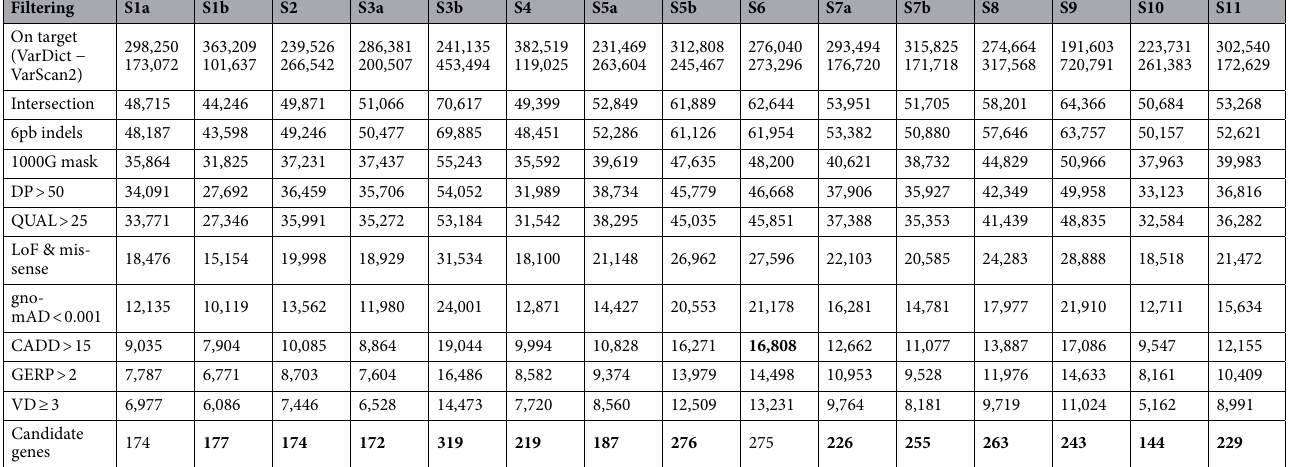
Table 2. Numer of called variants and after sequential variant filtering process for each sample. The last step where the causal somatic variant is retained is shown in bold.